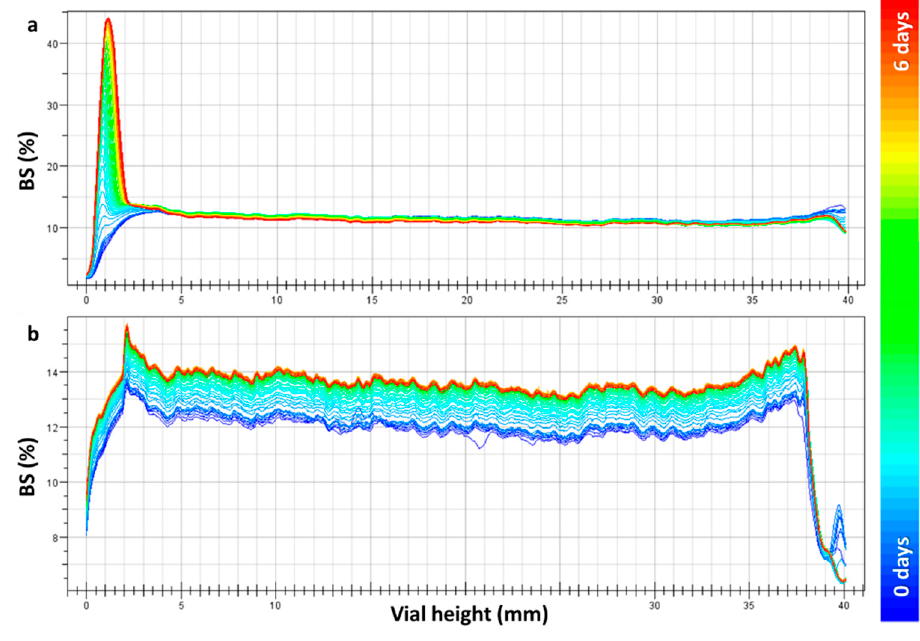
Figure 6. Backscattering profile vs. vials height acquired over 6 days. Signal comparison of the empty NVs ( a ) and Cu@BDHAC–NP-loaded NV hybrids ( b ) at an LIP:NPs ratio of 800:1 w/w .